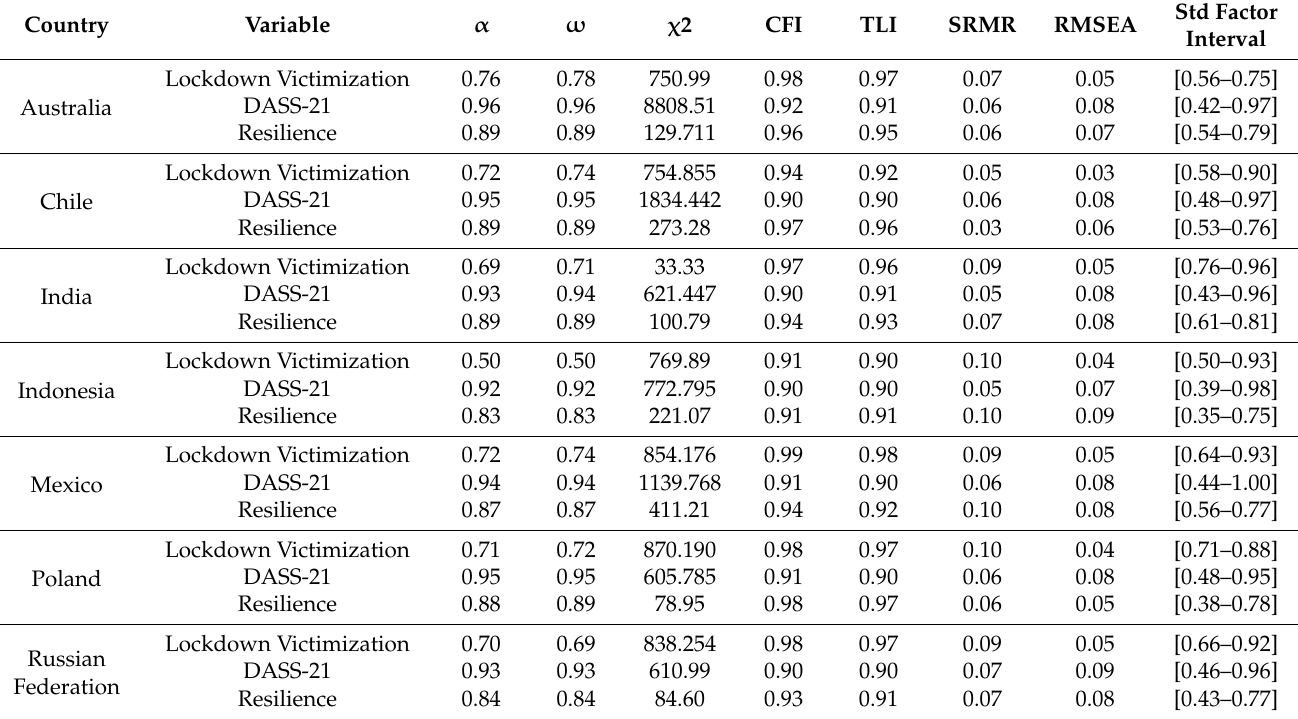
Table 2. Reliability analysis and confirmatory factor analysis (CFA) fit indexes of the